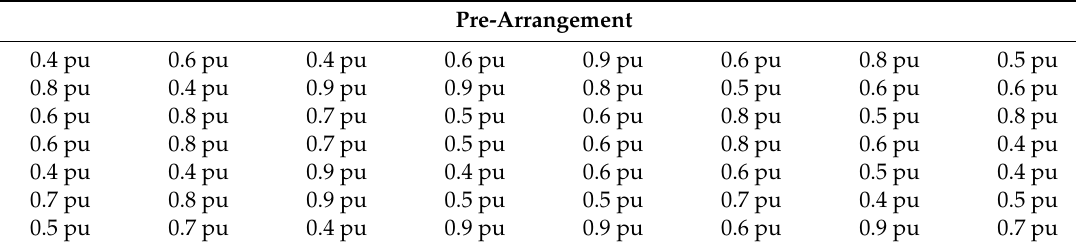
Table 7. PV array configuration for case